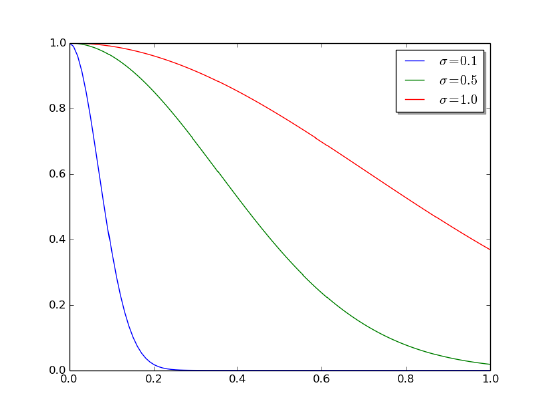
Figure 3: The shapes of the Gaussian function with different σ values are displayed. nodes and common nodes, weights are always defined as infinity.